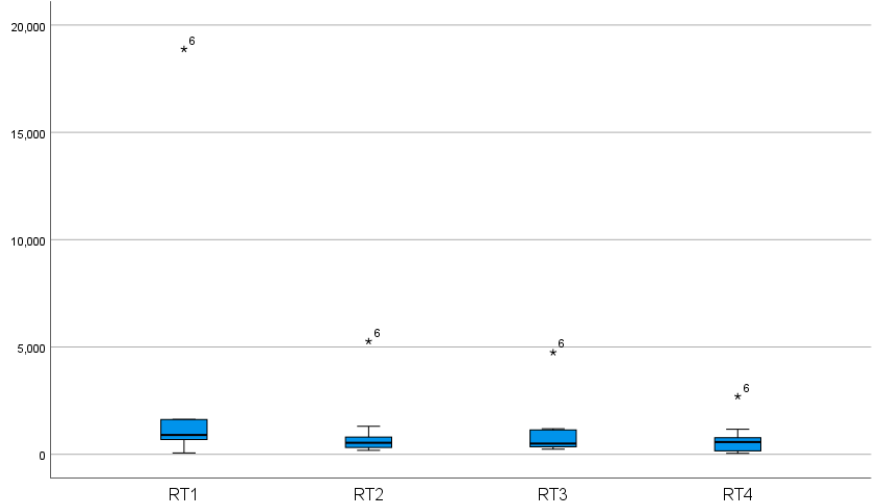
Figure 7. Reaction time (msec) of the individual threshold stereo acuities for the static stereo test. The results of the total group before training (RT1), after three weeks of training/ n = 1536 trials (RT2), after six weeks of training/ n = 3072 trials (RT3), and after six months without training (RT4). *, 6 : Participant number six shows an improvement of 14.131 msec and a much slower reaction time at the beginning of the training than the rest of the group and represents an “extreme outlier” in the box plot diagram.